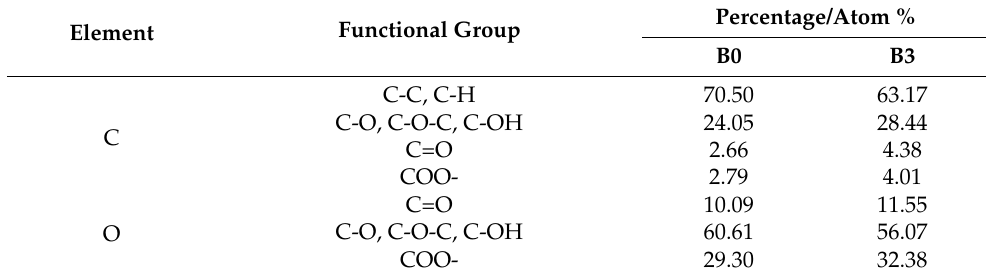
Figure 5. The XPS C1s and O1s spectra of cokes: ( a ) C1s of B0 coke; ( b ) C1s of B3 coke; ( c ) O1s of B0 coke; ( d ) O1s of B3 coke [67]. Table 4. C and O containing functional groups in B0 and B3 coke analyzed by XPS